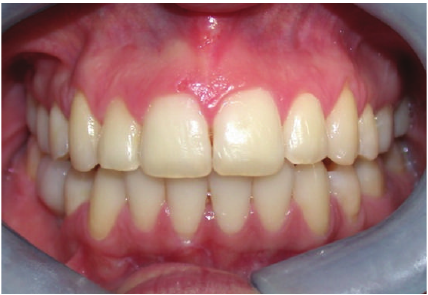
Figure 19: Clinical view of definitive crown.